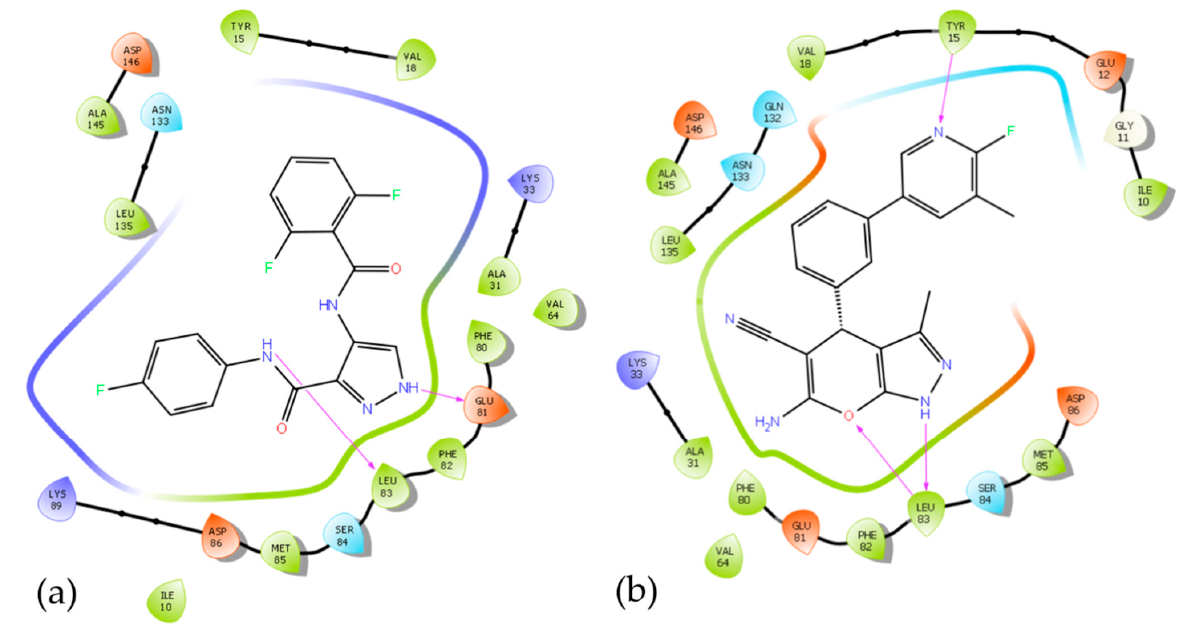
Figure 6. 2D Interaction diagram of ligand ( a ) and 5b ( b )with CDK1.